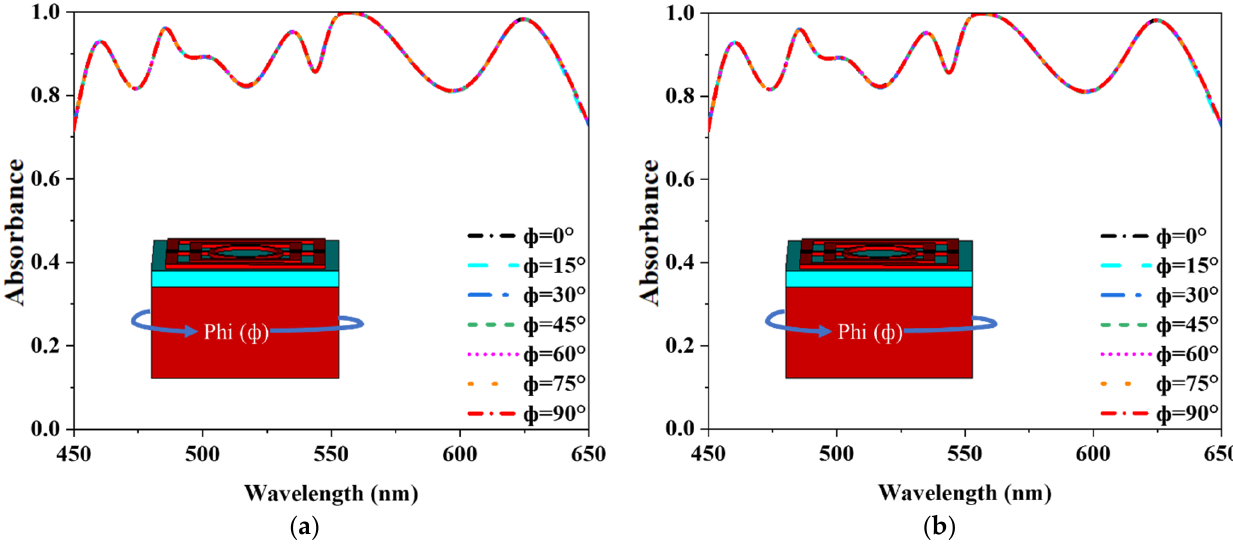
Figure 10. Illustration of the polarization independency of the MA ( a ) TE mode and ( b ) TM mode.